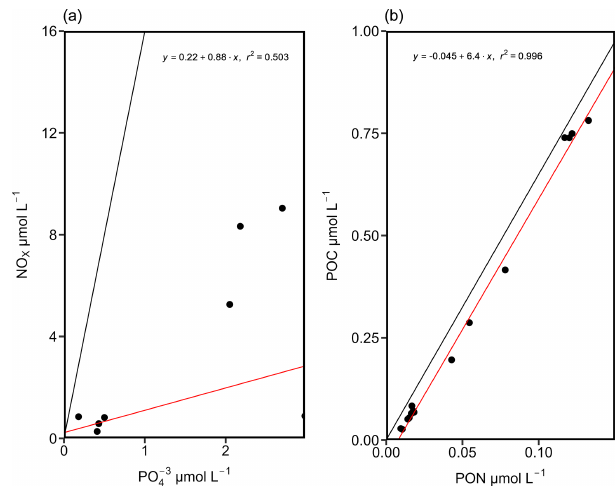
Figure 3. N : P (a) and C : N (b) ratios from stations KB06, BB23, BB15, BB08, and GB107. The black lines depict the N : P (16 : 1) and C : N (106 : 16) ratios after Redfield. The red lines indicate the trend lines of our data. An N : P ratio below the canonical Red- field ratio of 16 : 1 suggests a niche for N 2 fixation. However, the positive intercept speaks for DIN still being available, which might be considered unfavorable for N 2 fixation (a) . A C : N ratio below Redfield might suggest a slight deficiency in N (b) , and this might result from degrading organic matter in the particulate organic mat- ter (POM)